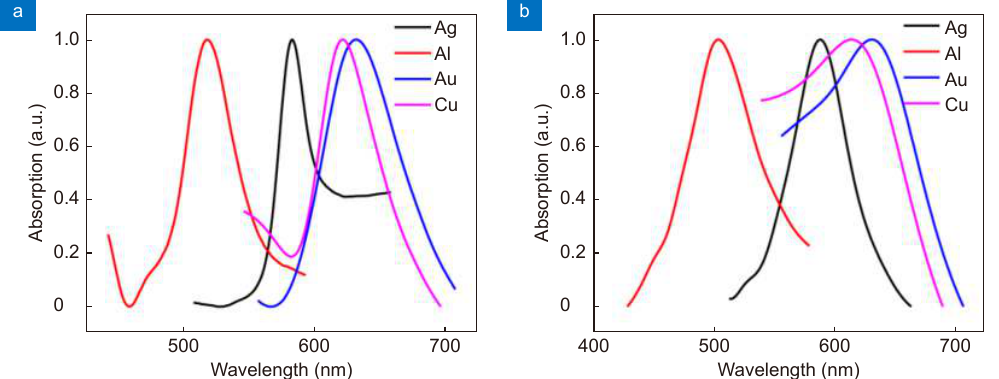
Fig. 3 | ( a ) Measured and ( b ) simulated absorption spectra of OLEDs based on Ag, Al, Au, Cu metal cathodes